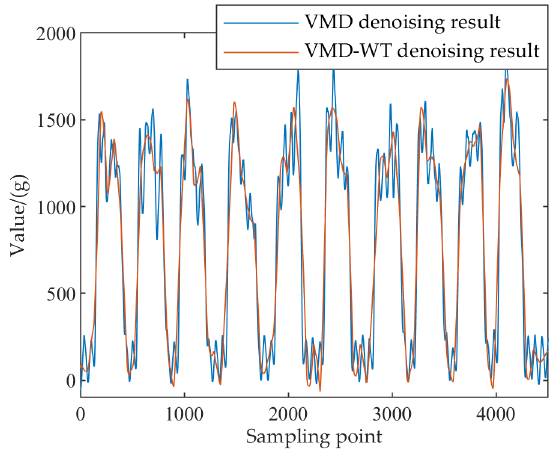
Figure 7. Comparison of VMD and VMD − WT denoising results of the tea dynamic weighing sig- nal.